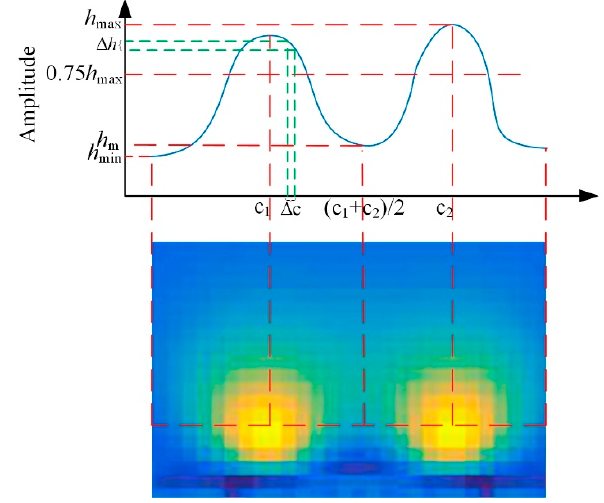
Figure 7. The schematic diagram of Ra and Ag with two inclusions.